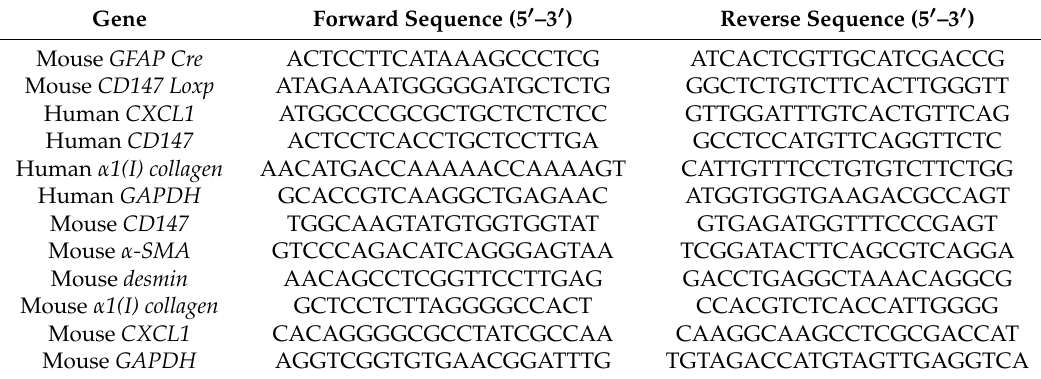
Table 1. Sequences of PCR